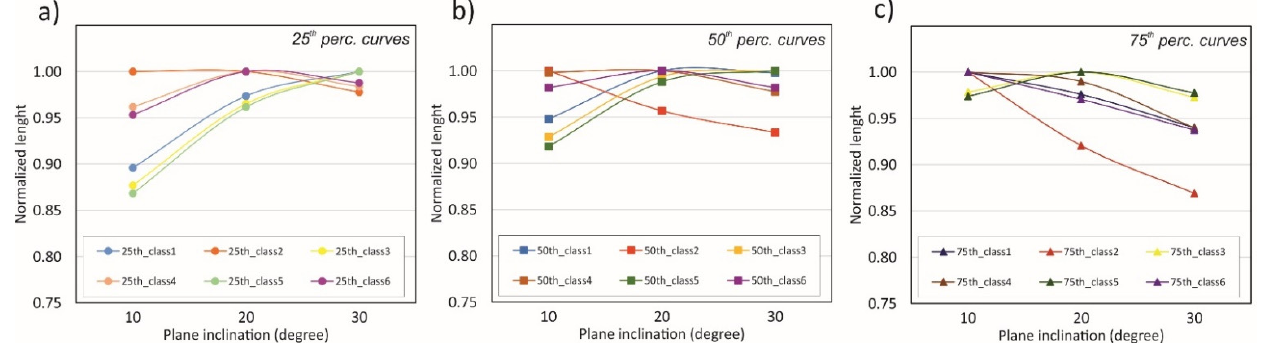
Figure 8. Diagrams showing the effects of the inclination of the planes on the lengths of the lava flows originating from the 25th ( a ), 50th ( b ) and 75th ( c ) percentile curves. The lengths were normalized with respect to the highest value estimated for each characteristic curve and the associated eruptive class.